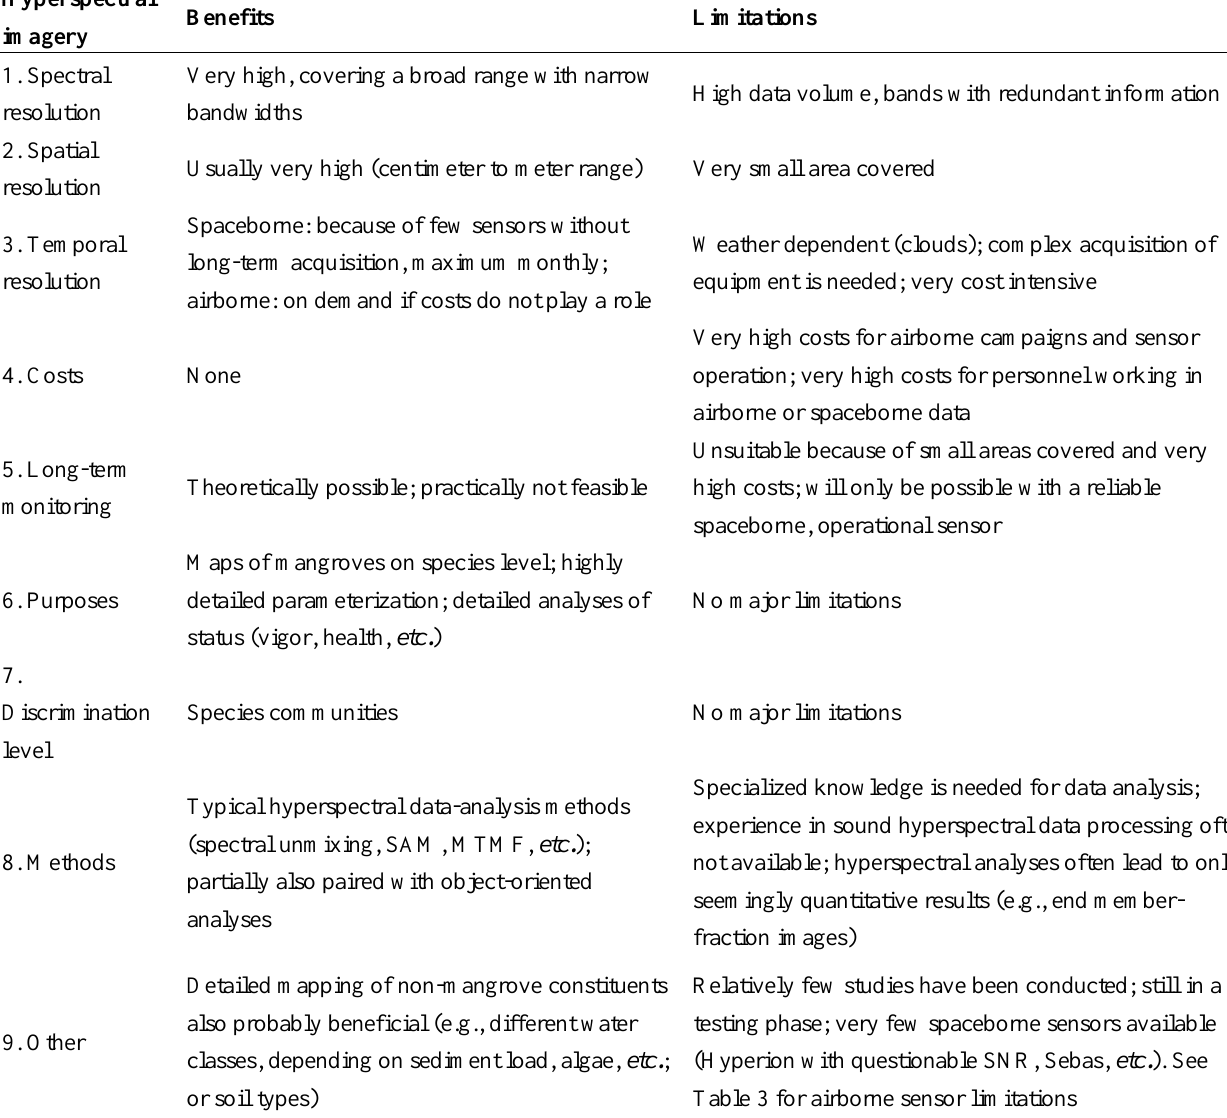
Table 3 for airborne sensor